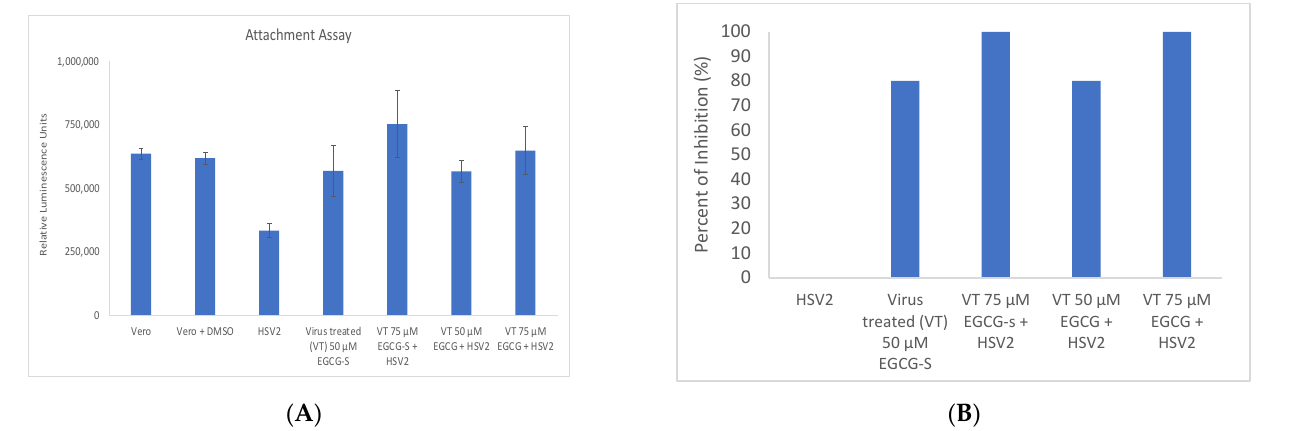
Figure 4. ToxGlo TM attachment assay with Vero cells infected at 4 °C with HSV-2 (MOI = 0.1) pre- treated for one hour with 50 µM EGCG-S, 75 µM EGCG-S, 50 µM EGCG, and 75 µM EGCG, and Vero cells infected with untreated HSV-2 as control at 4 °C. ( A ) The antiviral effects of EGCG-S on the binding step of the viral cycle are reported. Cell viability was measured by the luminescence of Vero cells following infection with HSV-2 treated with 50 and 75 µM concentrations of EGCG and EGCG-S, respectively. ( B ) The results of the percent inhibition resulting from the treatment of HSV- 2 with 50 and 75 µM concentrations of EGCG and EGCG-S are reported. Seventy-five µM concen- trations of EGCG and EGCG-S, respectively, resulted in 100% inhibition of attachment to Vero cells. 3.5. EGCG and EGCG-S Reduce HSV-2 Penetration in Vero Cells Vero cell monolayers were exposed to HSV-2 to allow attachment, but not penetra- tion (as described in the Methods section) [43,44]. Cells were subsequently treated with 50 µM EGCG-S, 75 µM EGCG-S, 50 µM EGCG, and 75 µM EGCG, respectively, and then the virus was allowed to penetrate the cells. These results (Figure 5A,B) suggest that 50 µM EGCG-S, 75 µM EGCG-S, inhibit penetration 50.3% and 54.1%, respectively, and 50 µM EGCG, 75 µM EGCG inhibit penetration of HSV-2 57.3% and 23.6% respectively in Vero cell monolayers ( p < 0.05; Student’s t -test).